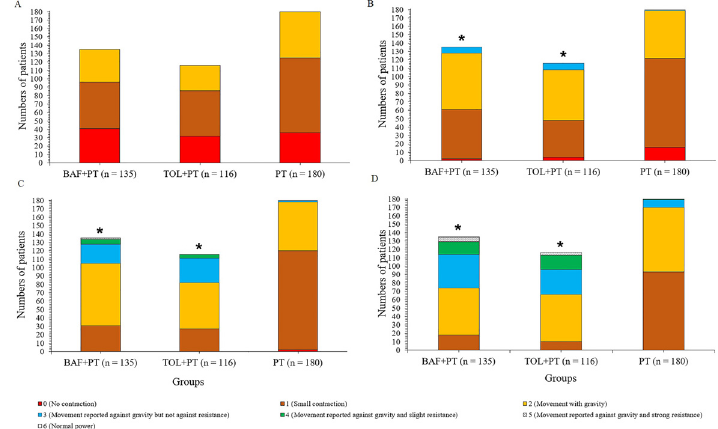
Figure 3. The modi fi ed Medical Research Council score of patients at different points of evaluation. A , Before the start of interventions. B , C , and D , at 2, 4, and 6 weeks after the start of interventions, respectively. *P o 0.05 compared to the PT group (ANOVA). BAF + PT: baclofen plus physical therapy; TOL + PT: tolperisone plus physical therapy; PT: physical therapy alone.